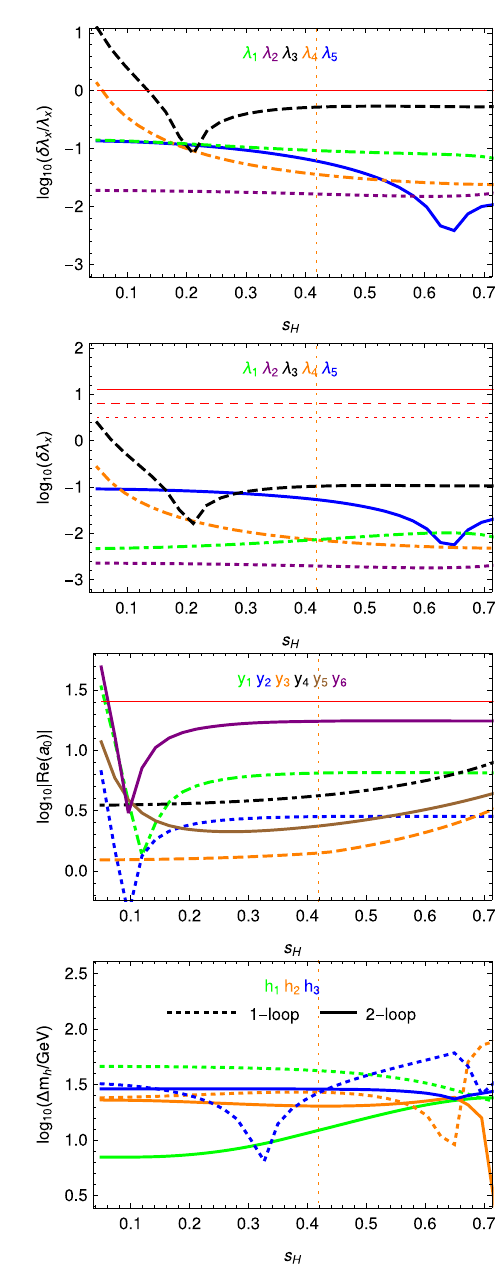
Fig. 5 On the left: the same as Fig. 3 for m H = 300 GeV with the ◦ additional condition α = 75 s H . On the right-hand side, we use rad input choice II as defined in Eq. (4.8), i.e. ( m h , m 5 ) as input instead